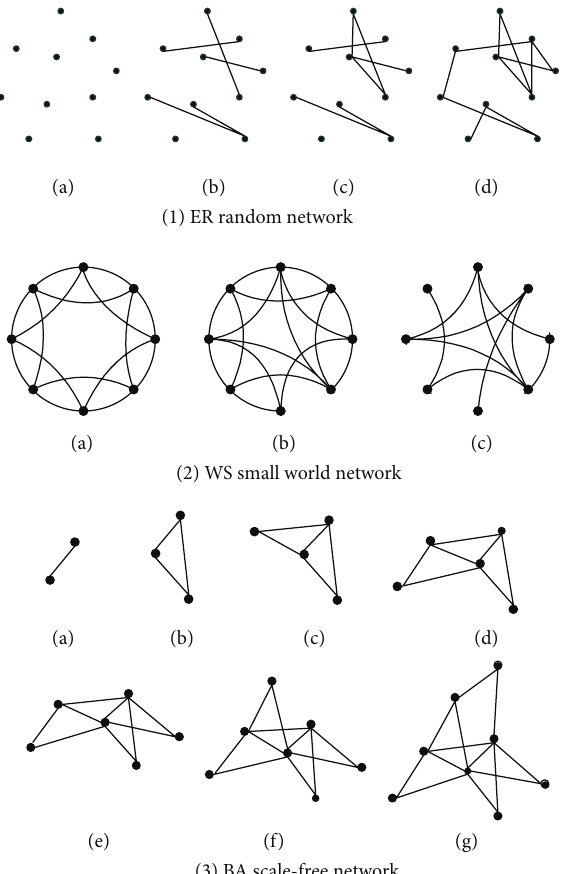
Figure 6: Process of building random network, small world net- work, and scale-free